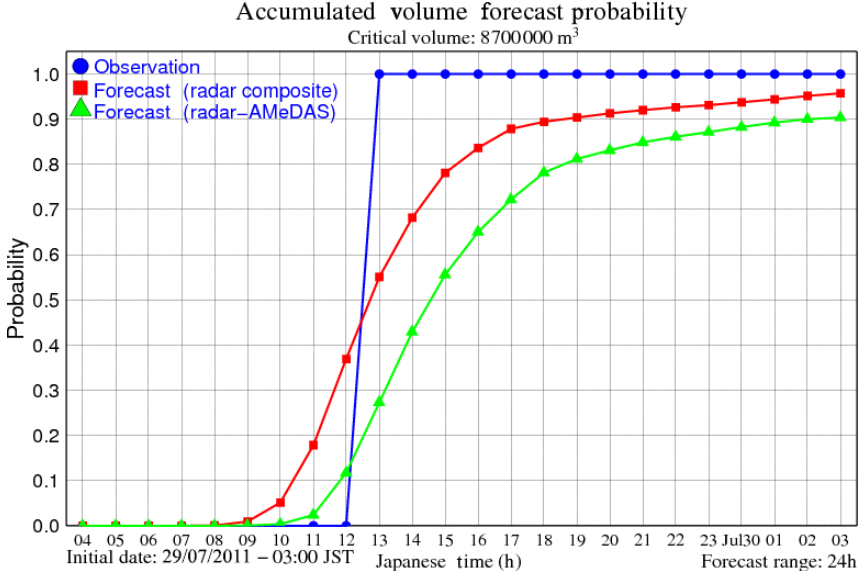
Figure 9. Probability that the dam needs emergency operation. Radar–AMeDAS and radar composite indicate the ensemble simulation with the parameters calibrated with the